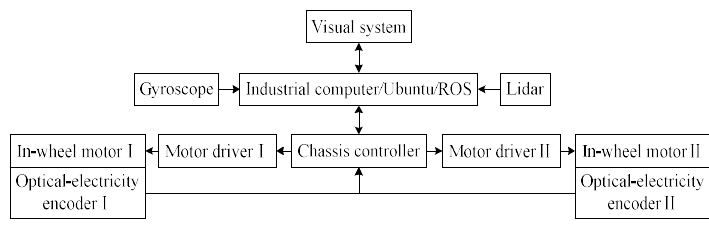
Figure 7. Navigation and positioning system.